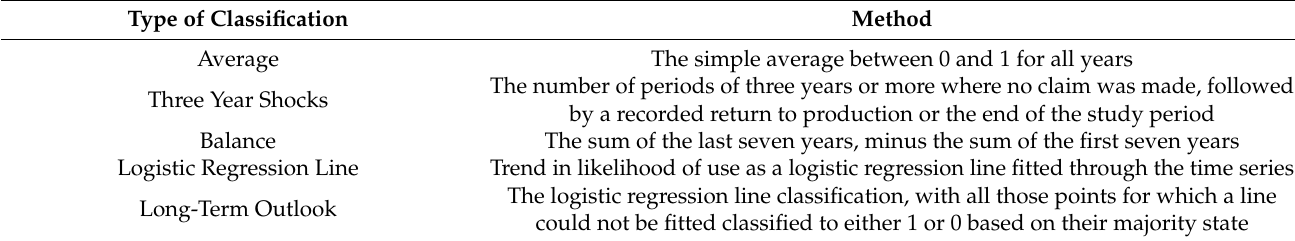
Table 2. The five classes of descriptive statistics and methodology